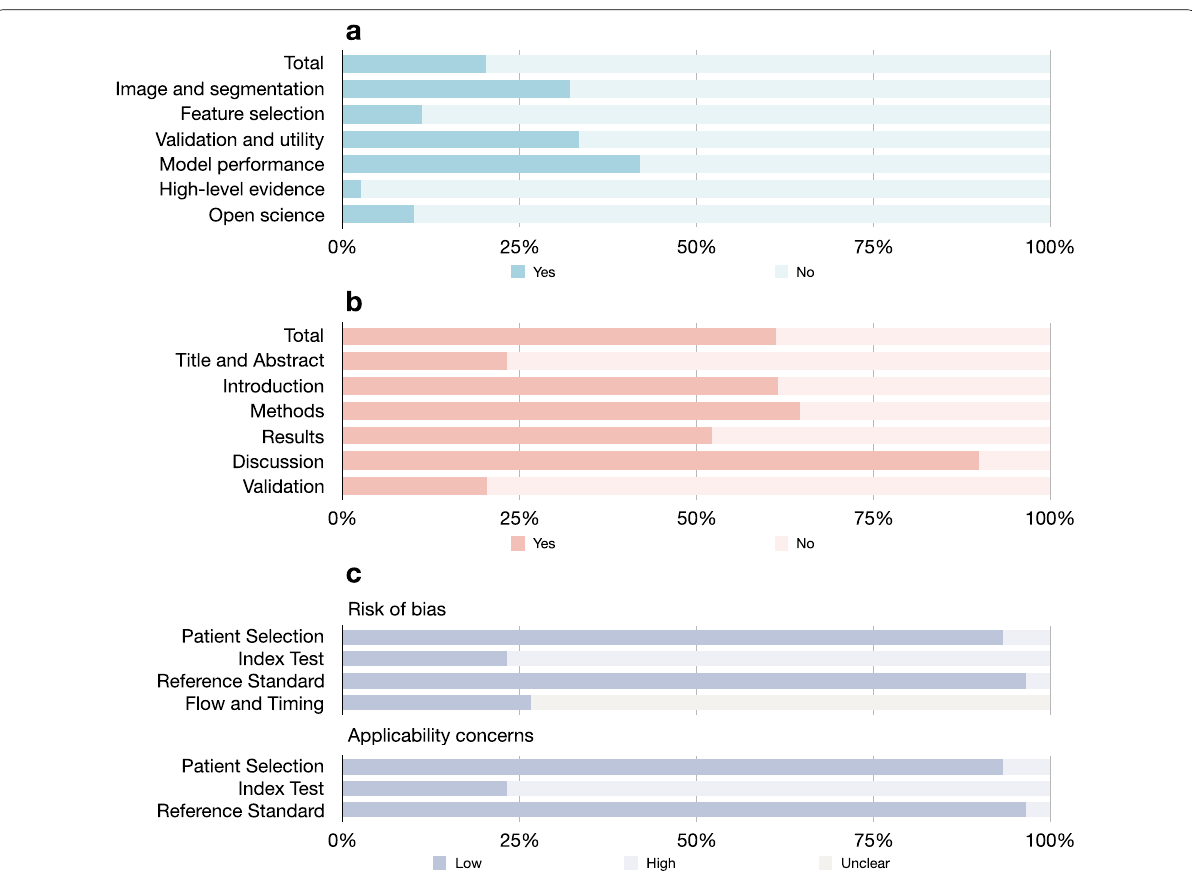
Fig. 3 Quality assessment of included studies. a Ideal percentage of RQS; b TRIPOD adherence rate; c QUADAS-2 assessment